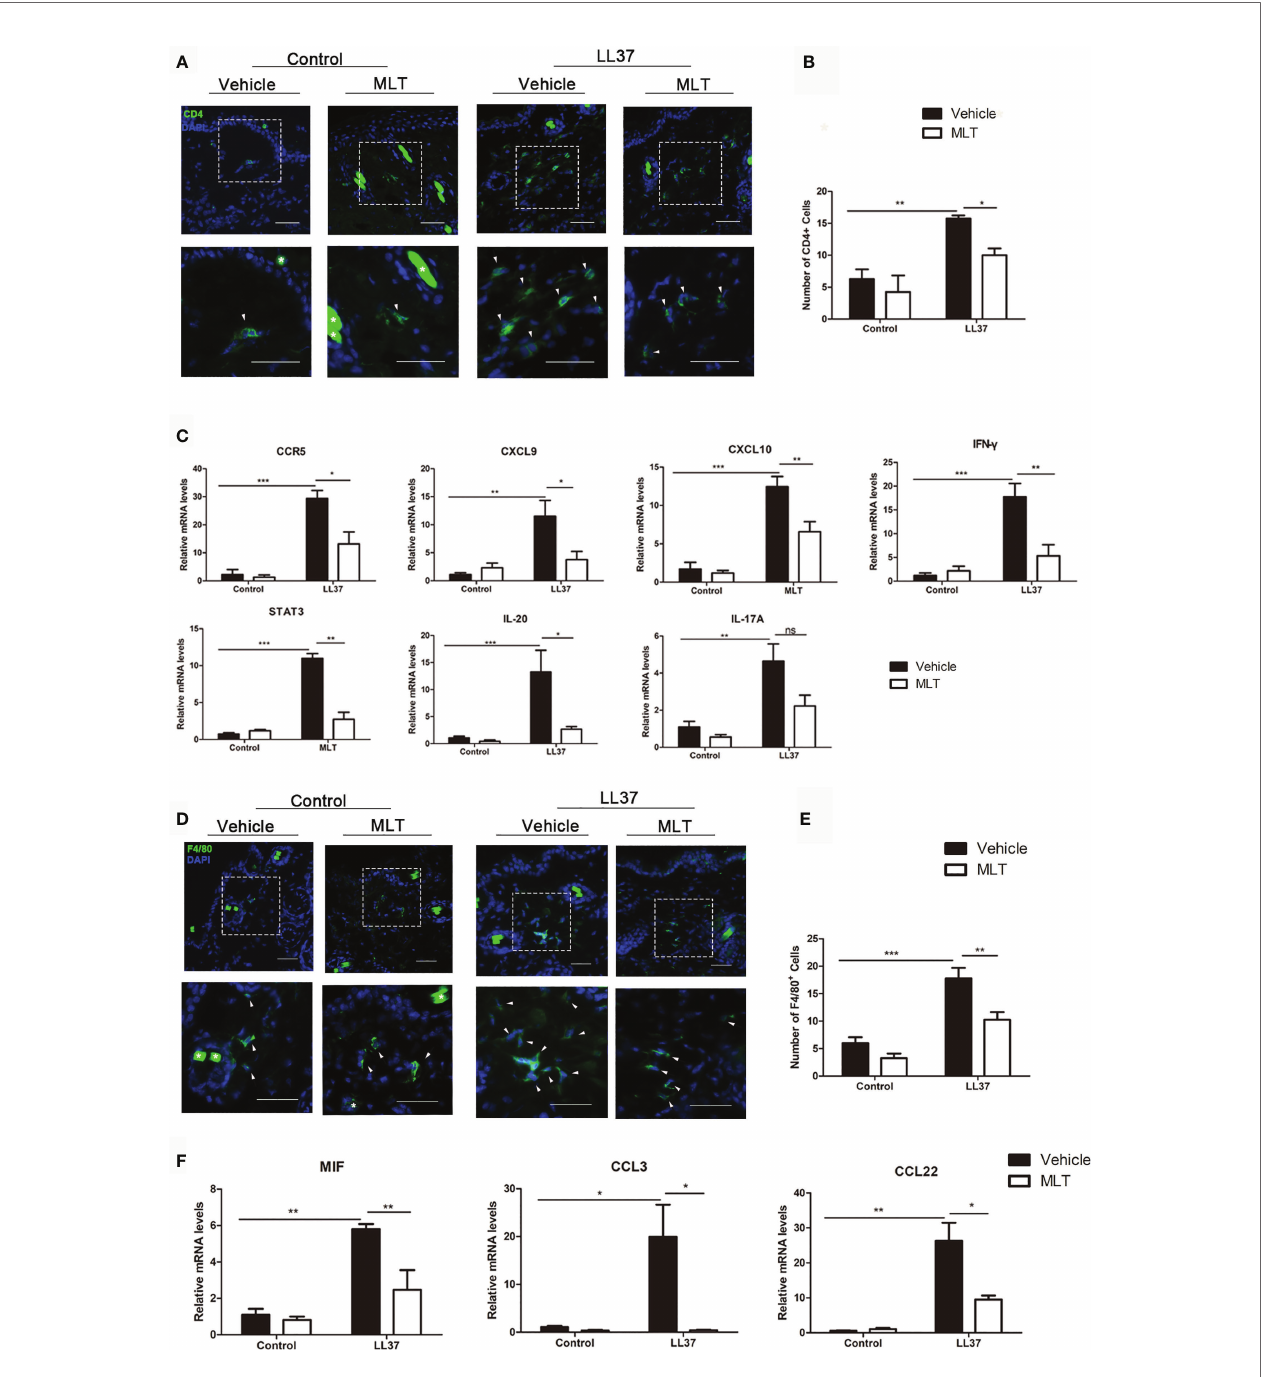
FIGURE 6 | MLT inhibits immune cell in fi ltration in rosacea-like mice. (A) Immunostaining of CD4 + T cells in rosacea-like mice. Scale bar: 50 m m. (B) The in fi ltrated CD4 + T cells were quanti fi ed. (C) qPCR analysis detected the expression of Th1- and Th17-related genes in rosacea-skin lesions. (D) Immunostaining of macrophages in rosacea-like mice. Scale bar: 50 m m. (E) The in fi ltration of macrophage cells was quanti fi ed in rosacea-like mice. (F) qPCR analysis detected the expression of macrophage-related genes. All results are representative of at least three independent experiments. Data expressed as individual values with mean ± SEM. * P < 0.05, ** P < 0.01, *** P <